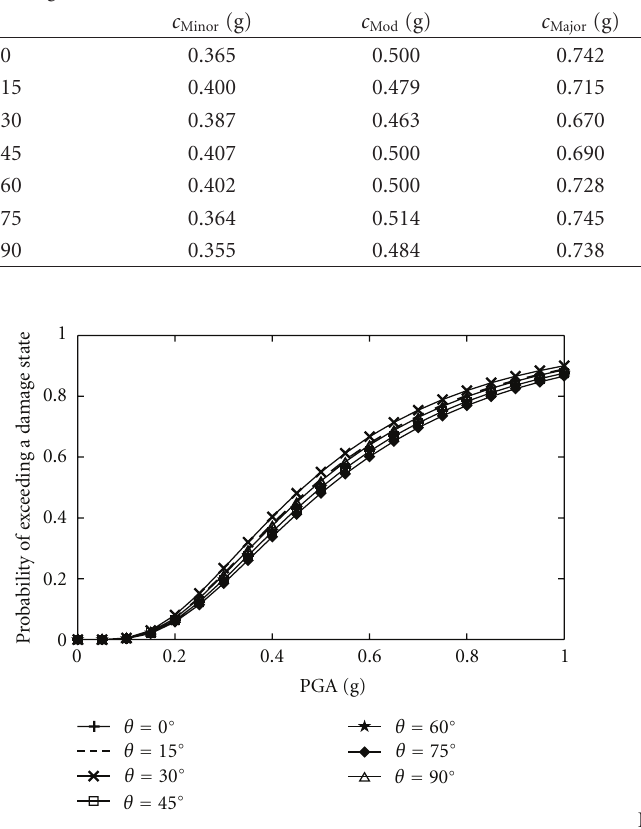
Table 3: Fragility parameters of the bridge at di ff erent θ for two orthogonal components of ground motion (case I). θ (degree)